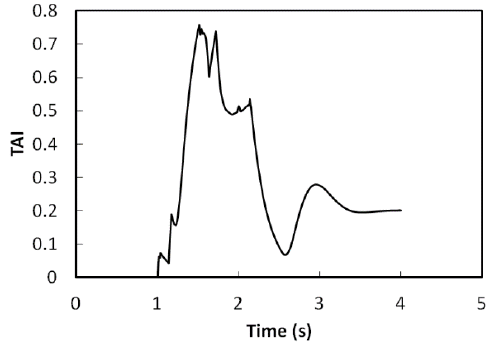
Figure 24. The TAI with upper level